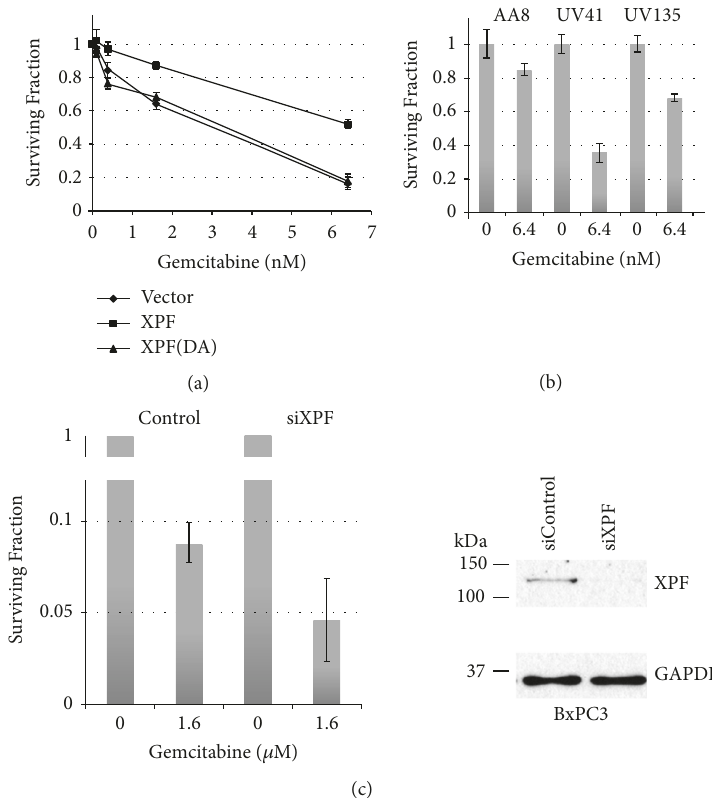
Figure 1: XPF is required for the cellular resistance to gemcitabine . Impact of XPF on gemcitabine sensitivity was examined by clonogenic survival assay. Cells were seeded one day before the gemcitabine treatment in 12-well plates. The indicated concentrations of gemcitabine were added and the cells were exposed to gemcitabine throughout the 5 ∼ 7 days of incubation. After fixing, the cells were stained with Crystal violet. Surviving fraction was calculated by dividing number of cells with gemcitabine by number of cells without gemcitabine. Three independent experiments were performed and averages of surviving fraction are plotted. The error bars show standard deviations. (a) XPF-deficient UV41 cells are sensitive to gemcitabine and the endonuclease activity of XPF is required for the cellular resistance to gemcitabine . UV41 with vector alone (closeddiamond)aresensitivetogemcitabinecomparedtotheUV41reconstitutedwithhumanXPFgene(closedsquare).ReconstitutedUV41 with human XPF gene (closed square) restored resistance to gemcitabine while the endonuclease-deficient XPF (XPF-DA) (closed triangle) failed to restore the gemcitabine resistance. The difference in the gemcitabine sensitivity at each concentration is statistically significant with P < 0.01. (b) Nucleotide excision repair (NER) contributes to the cellular resistance to gemcitabine . A NER deficient UV135 showed a moderate sensitivity to gemcitabine compared to the sensitivity in UV41. The differences in the gemcitabine sensitivity at 6.4 𝜇 M between AA8 and UV41, AA8 and UV135, and UV41 and UV135 are statistically significant with P < 0.05 . (c) Suppression of XPF in pancreatic cancer cell line BxPC3 sensitizes cells to gemcitabine . The expression of XPF was suppressed by siRNA in pancreatic cancer cell line BxPC3 and the cellular sensitivitytogemcitabinewasexamined.ThedifferenceinthegemcitabinesensitivitybetweensiControl-andsiXPF-treatedcellsisstatistically significant with P < 0.05. The western blots showed the suppression of XPF. The expression of XPF was significantly reduced (more than 95%) with the siRNA treatment. GADPH was used as a protein loading